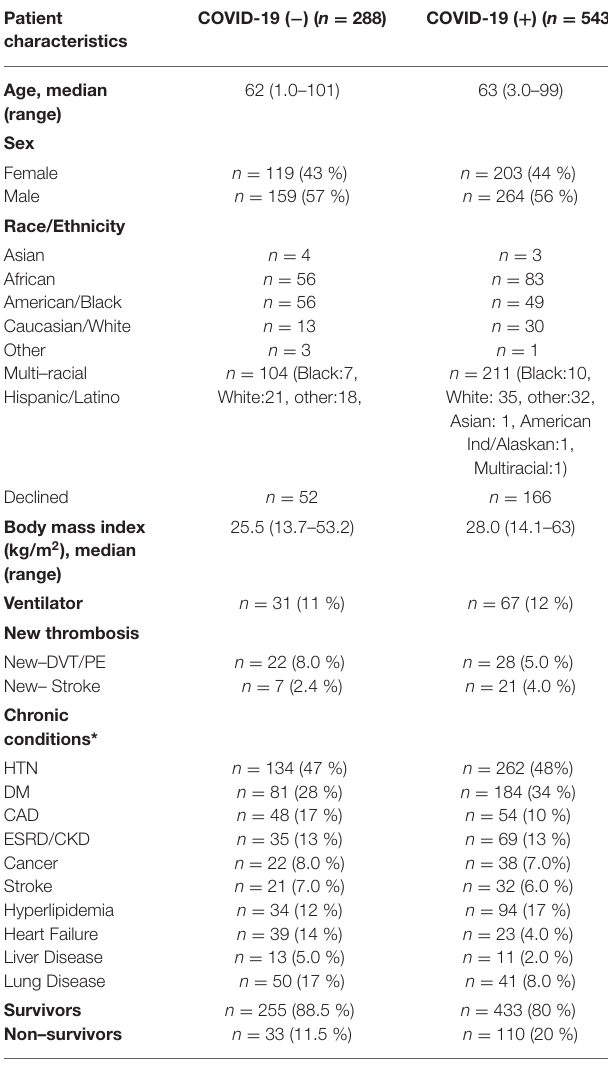
TABLE 1 | Patient demographics and clinical